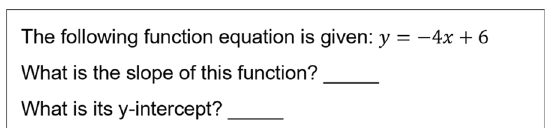
Fig. 4 Sample test item capturing basic conceptual knowledge about the parameters. Adapted and translated from Nitsch, 2015, p. 256, Fig. 46 (adapted and translated by permission from Springer Nature Customer Service Centre GmbH: Springer, Diagnose von Lernschwierigkeiten im Bereich funktionaler Zusammenhänge by R. Nitsch, © 2015)